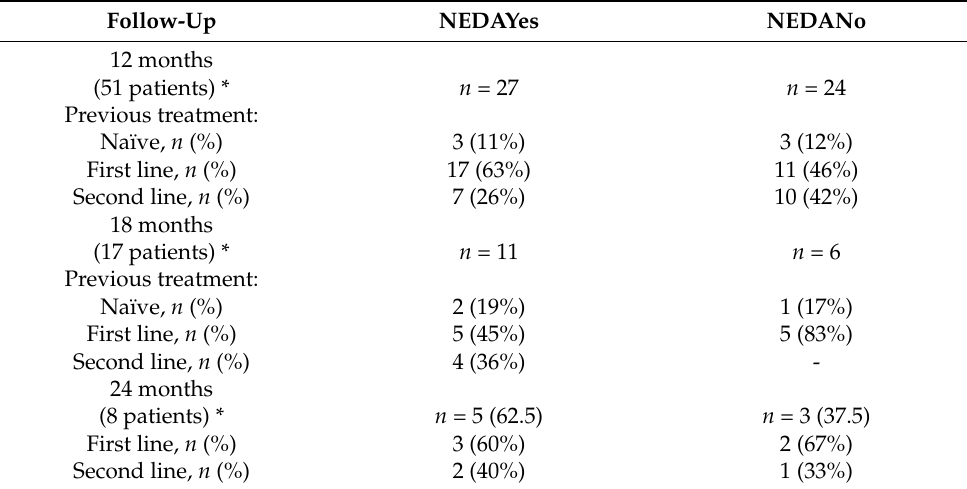
Table 2. No evidence of disease activity (NEDA) results in the multiple sclerosis patient cohort at 12, 18 and 24 months.